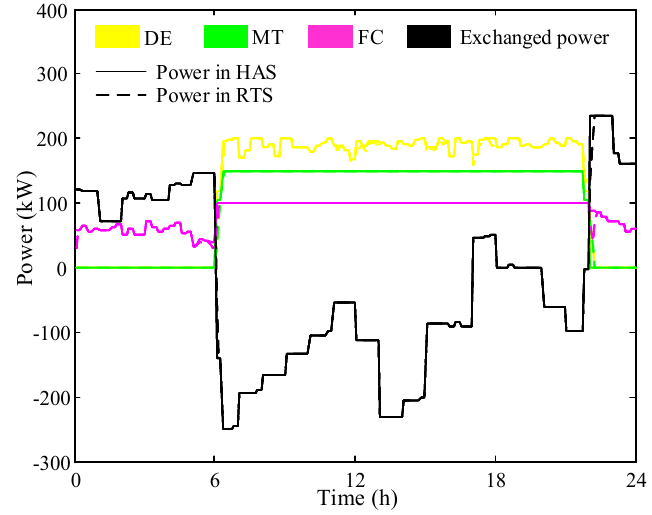
Figure 8. Operation results of the CDG and exchanged power in HAS and RTS.